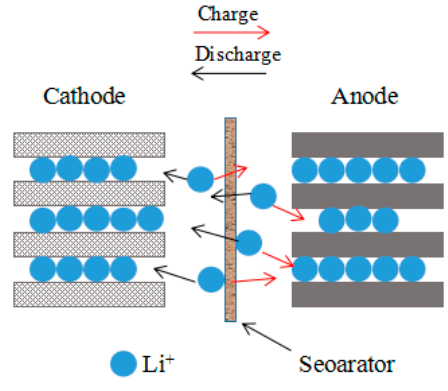
Figure 12. The schematic of yjr electrochemical model.